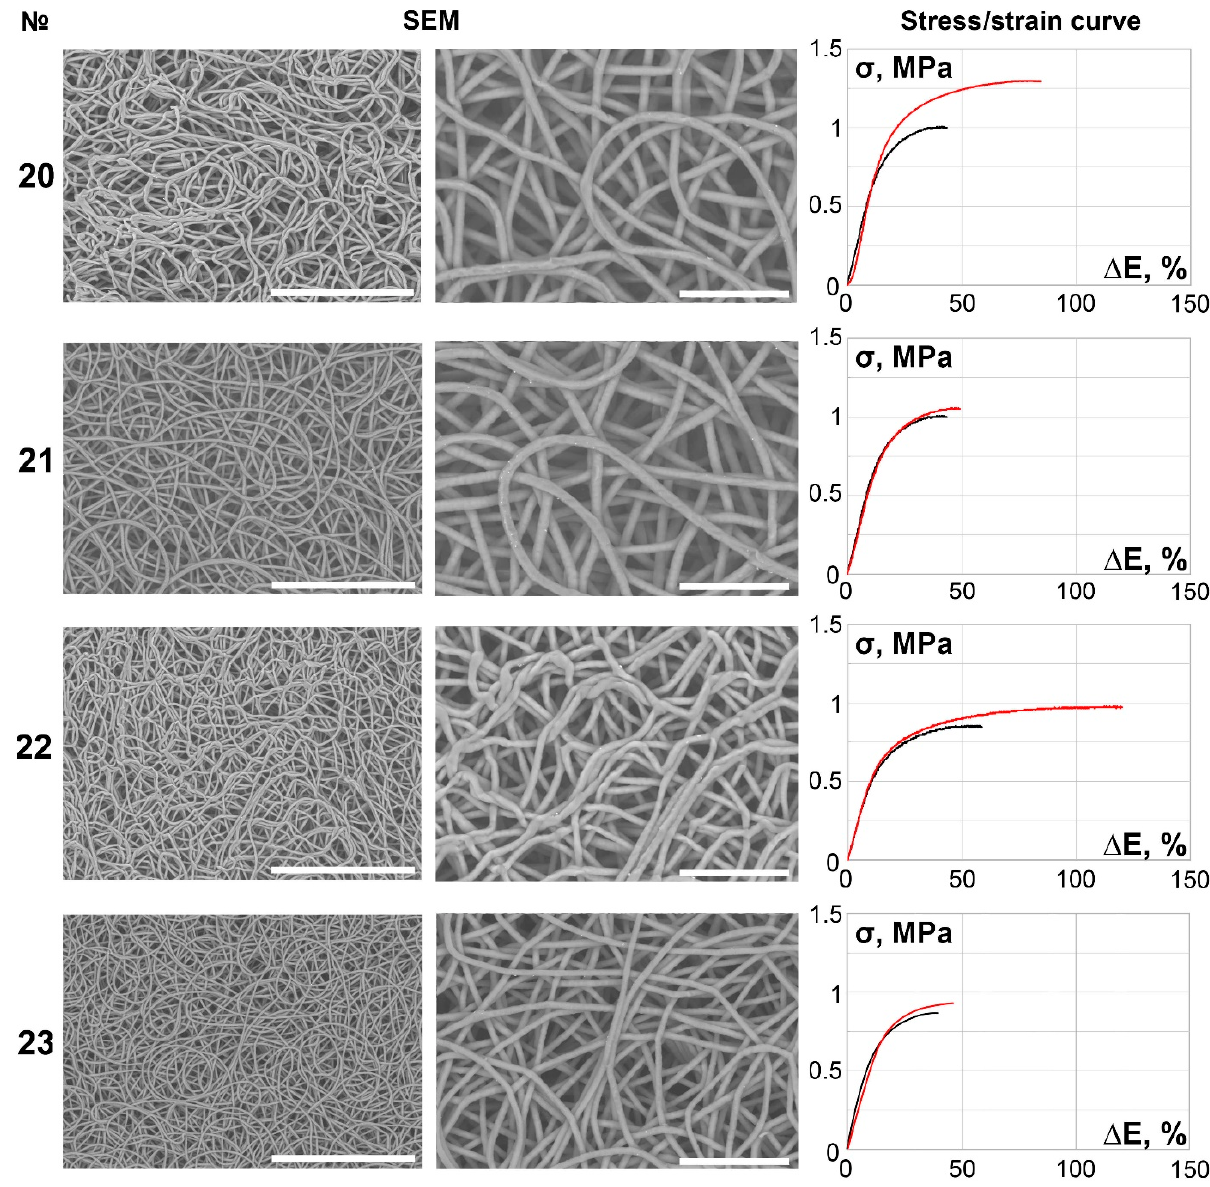
Figure 5. SEM images (×250 magnification, scale bar 200 µm and ×700 magnification, scale bar 50 µm) and stress/strain curves of tested 14% PCL samples. Red curves reflect stress/strain plotting in the axial direction; black curves correspond to circumferential stretching.